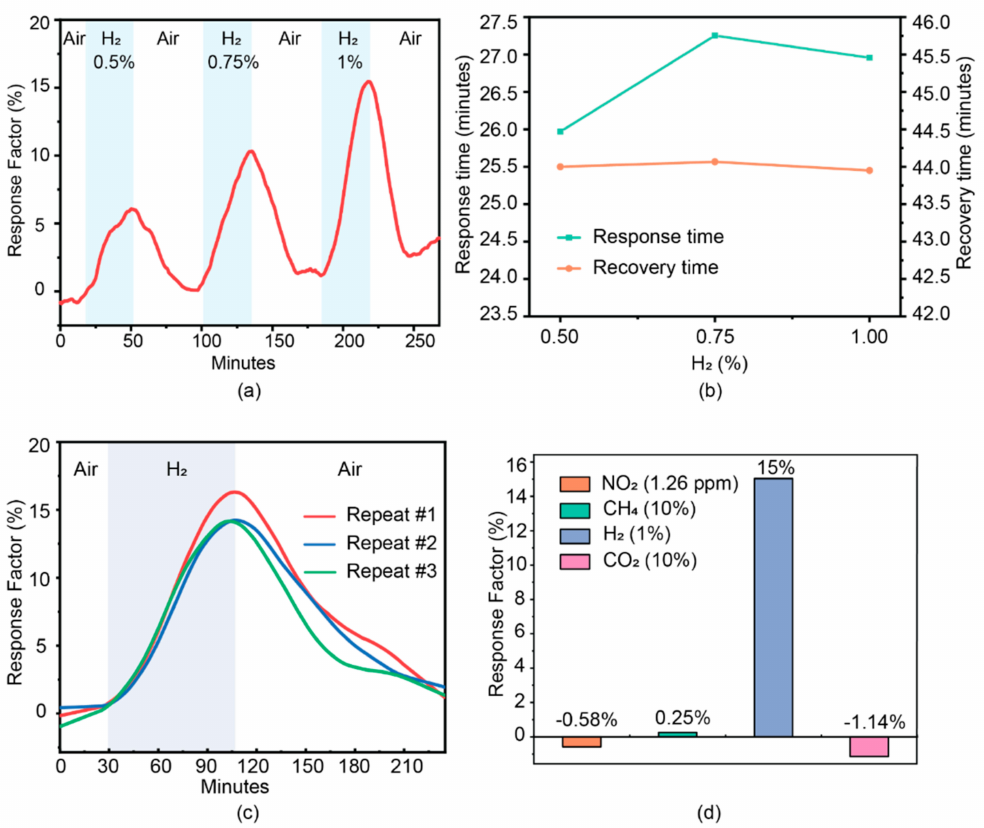
Figure 5. Gas sensing behaviors of the cobalt oxysulfide sensor at room temperature with ( a ) a dynamic response, ( b ) response/recovery time along with H 2 concentration, ( c ) repeatability experi- ments at 1% of H 2 , and ( d ) a selectivity comparison between NO 2 (1.26 ppm), CH 4 (10%), H 2 (1%), and CO 2